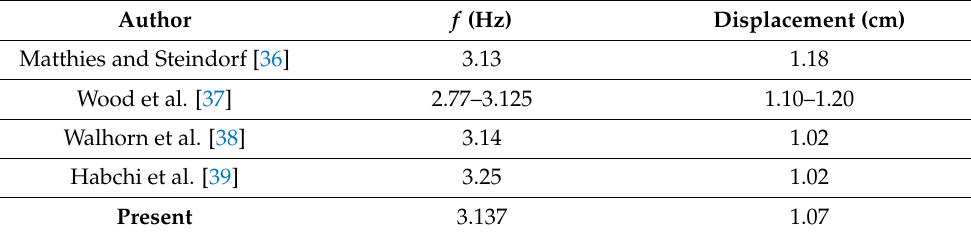
Figure 5. ( a ) The layout of the computational domain. ( b ) Displacement of the tip of the cantilever beam. Table 1. Comparison of present results with the open literature.